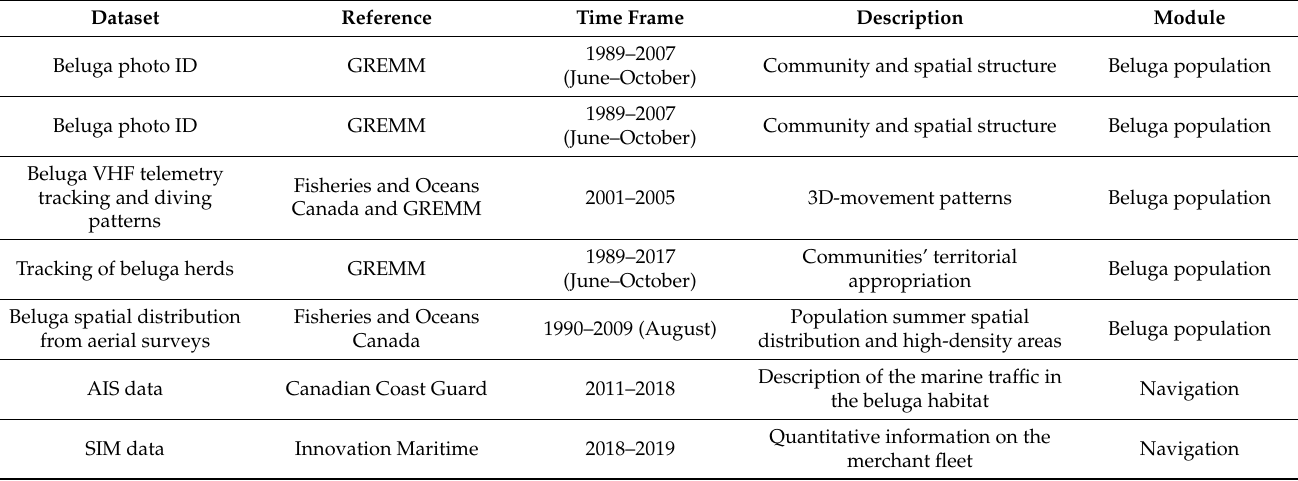
Table 1. Datasets used to inform the implementation of